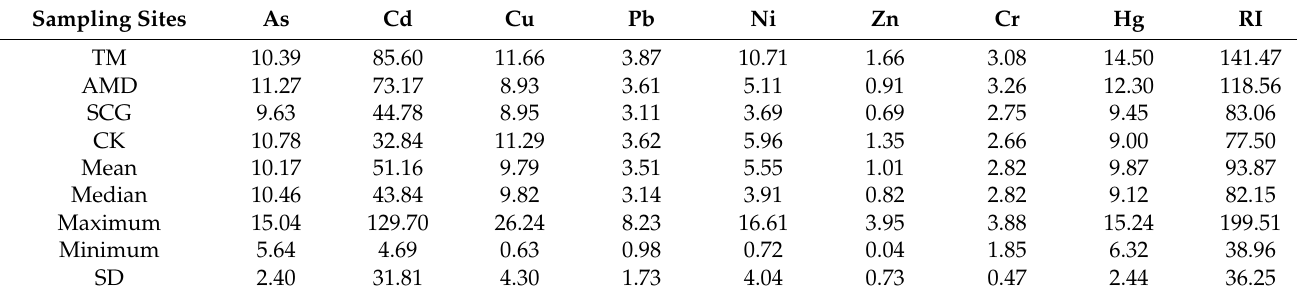
Table 2. The potential ecological risks of potentially toxic elements in soils from different sites of Youyu Catchment. Sampling